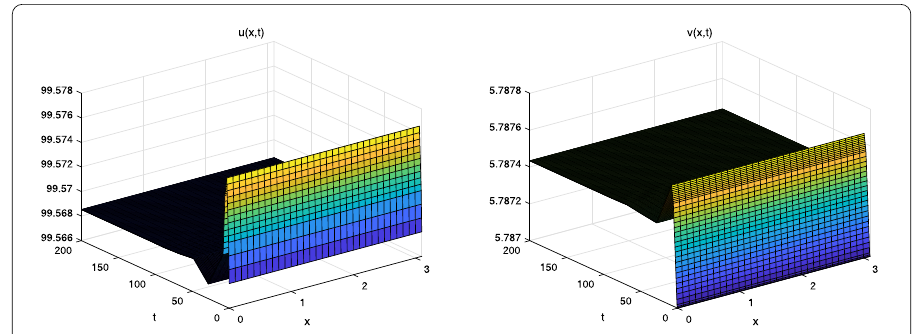
Figure 1 β = 0.5, d 1 = 1, d 2 = 0.3 and the initial condition is (99.568,5.787). P ∗ = ( u ∗ , v ∗ ) is locally asymptotically stable